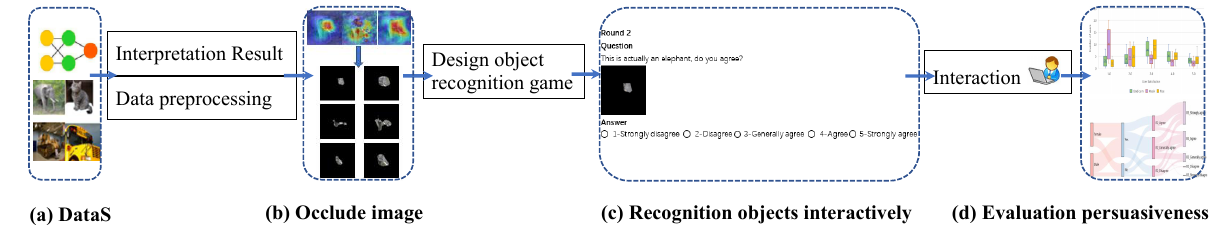
Figure 6. PE pipeline of interpretation methods. There are four steps in total: dataset (DataS), image occlusion, object recognition process and evaluation